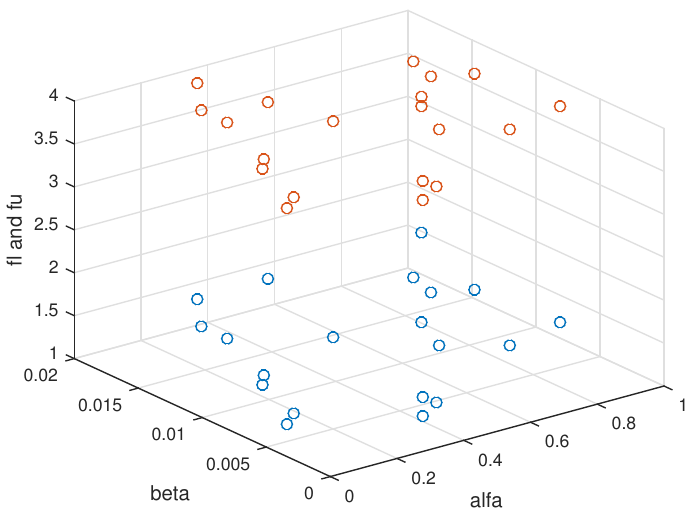
Figure 4. Efficient space for Example 3 without SOC constraint using n = 20.